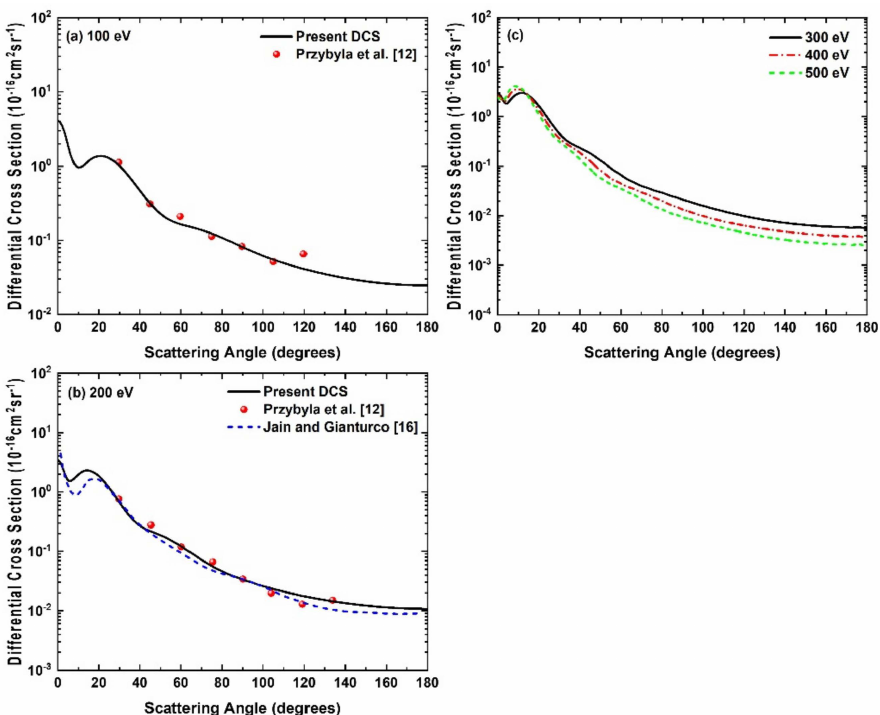
Figure 4. Differential cross sections for positron-CH 4 elastic scattering at incident positron energies ( a ) 100 eV, ( b ) 200 eV and ( c ) 300–500 eV. In ( a ) and ( b ); Solid line, present DCS; dashed line, Jain and Gianturco [16]; solid sphere, Przybyla et al.